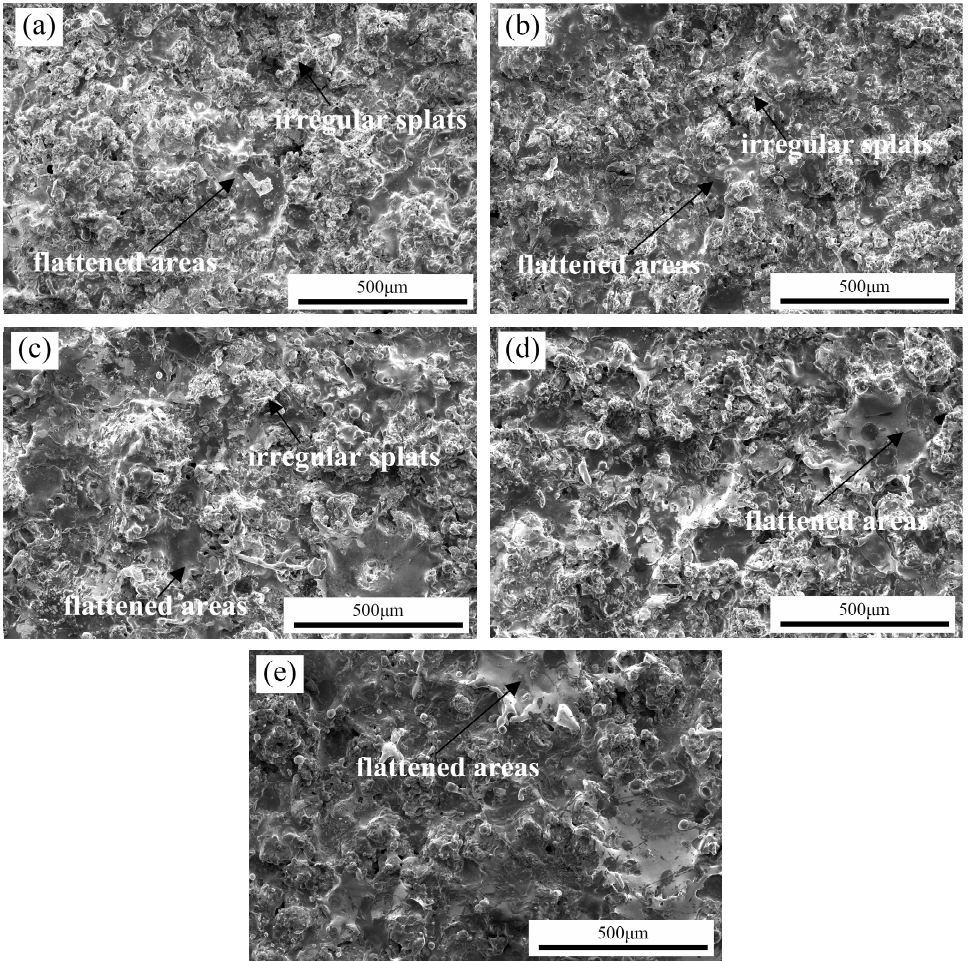
Figure 2. Surface morphology images of the coatings: ( a ) #A, ( b ) #B, ( c ) #C, ( d ) #D and ( e ) FeCrAl.